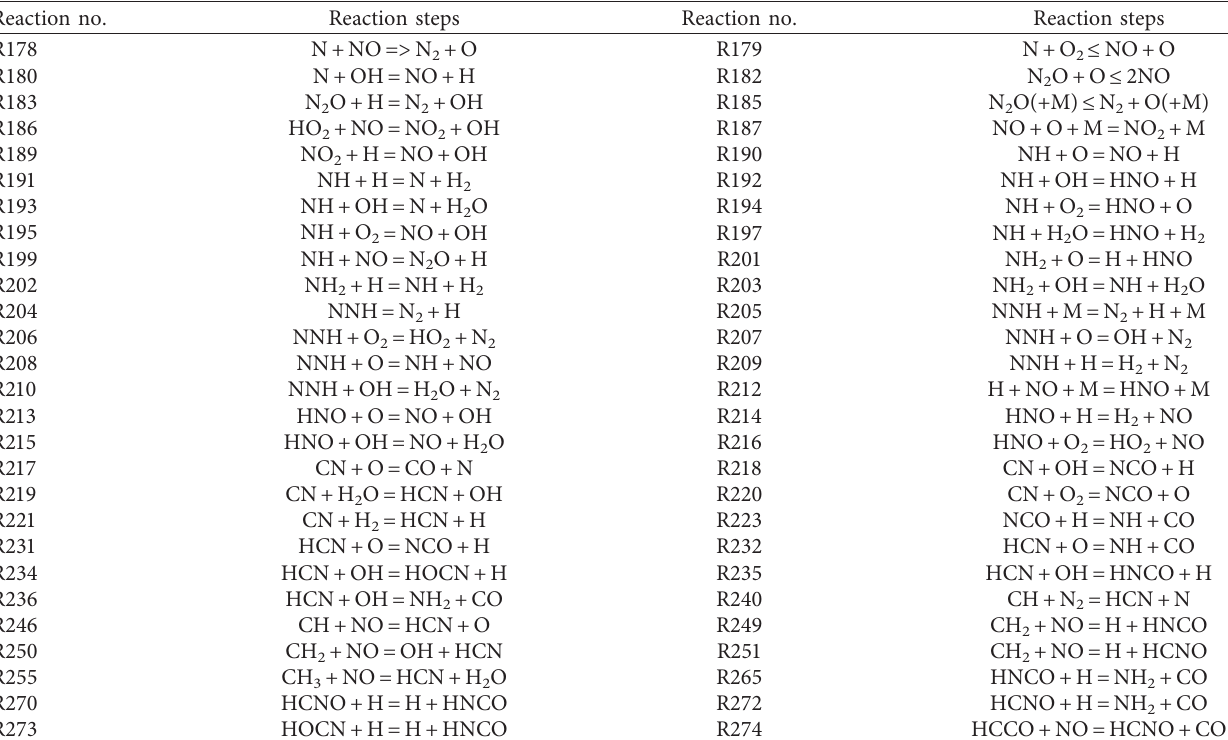
Table 2: Main reactions involved in NO formation (more information can be found in the GRI-Mech 2.11 mechanism [24]). Reaction